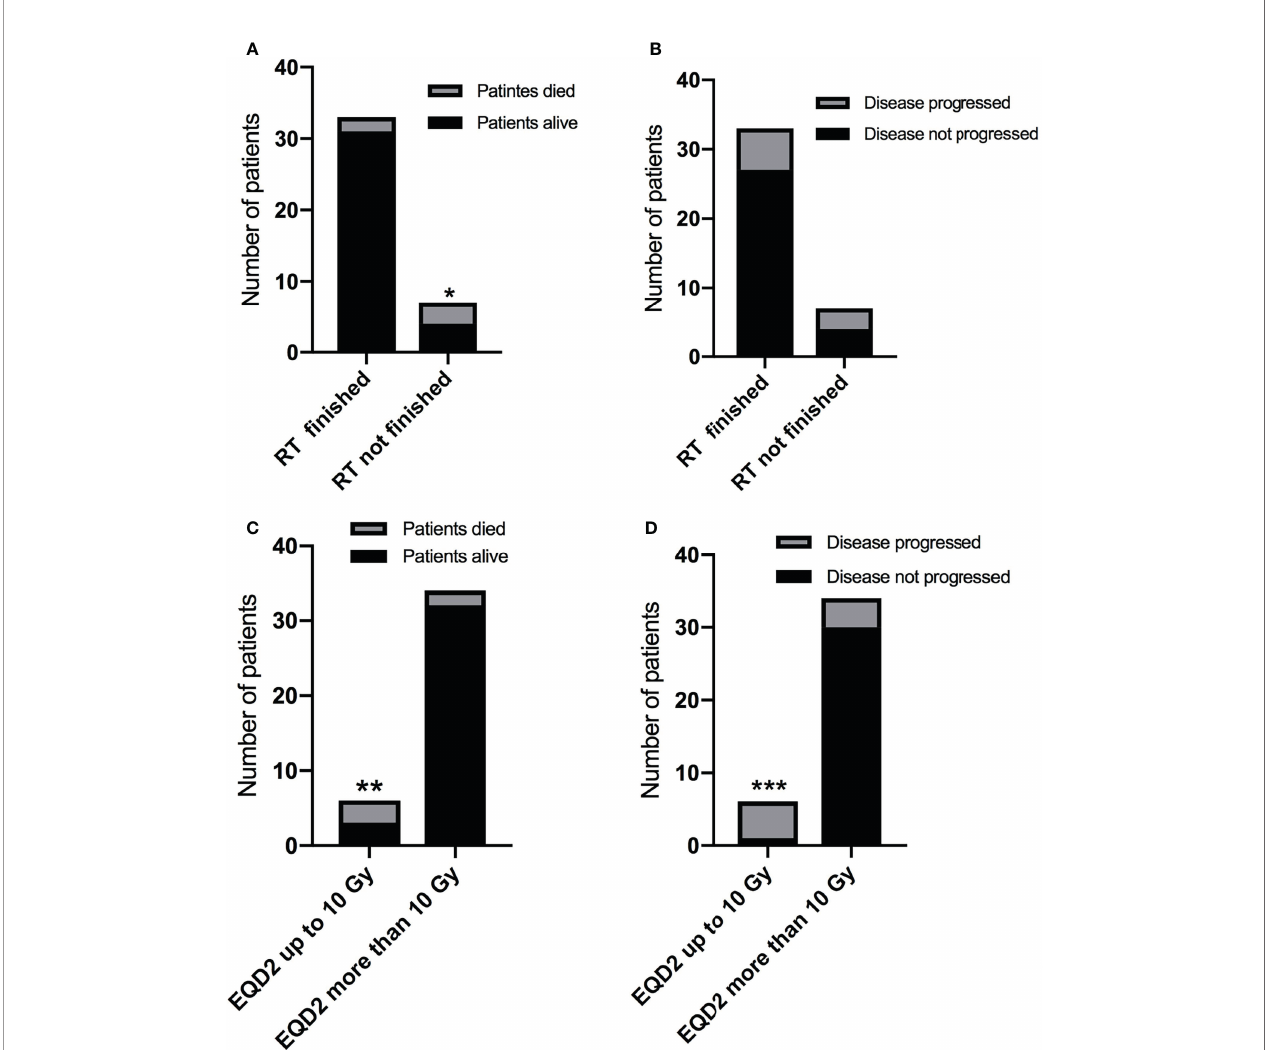
FIGURE 3 | The impact of RT interruption on disease progression and survival. (A) The impact of radiotherapy completion on survival. * p = 0.008. (B) The impact of radiotherapy completion on disease progression. P > 0.05. (C) The impact of gross tumor EQD2 (at the time point when RT was interrupted) on survival. ** p < 0.001. (D) The impact of gross tumor EQD2 (at the time point when RT was interrupted) on disease progression. *** p =